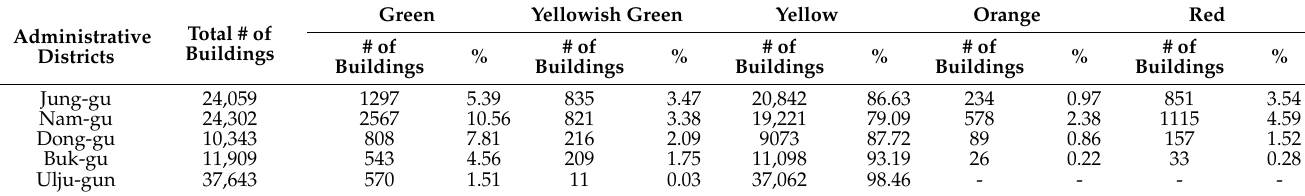
Table 5. Classification by building on urban flood vulnerability